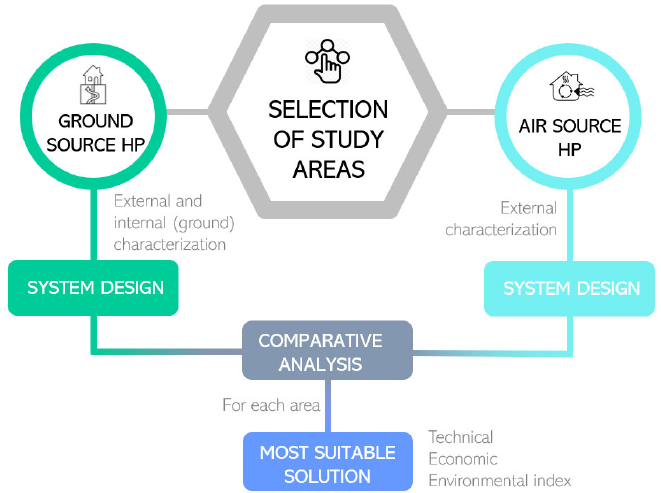
Figure 1. Workflow followed in the present research.